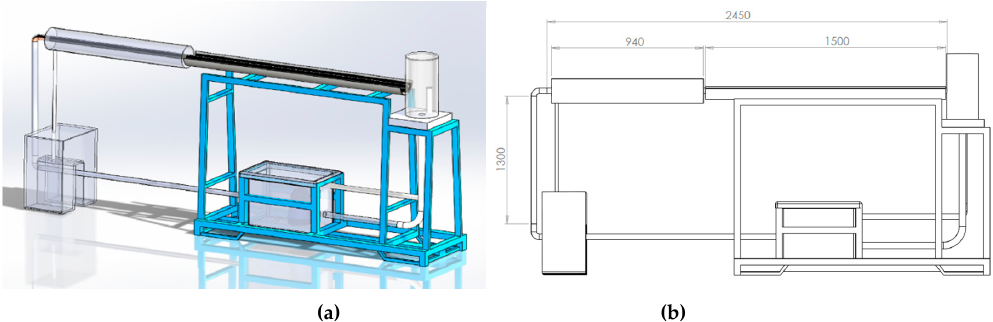
Figure 4. Parabolic trough Collector in ( a ) 3D and ( b ) 2D with dimensions in mm.